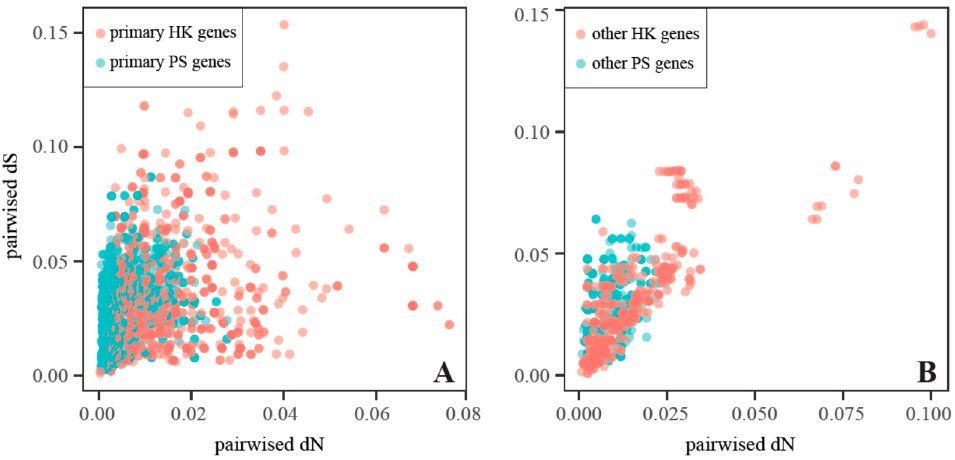
Figure 6. Bivariate plots of pairwise synonymous ( d S ) and nonsynonymous ( d N ) substitution rates of the protein-coding genes from the Myrsinaceae s.str. cp genomes. ( A ) Bivariate plot of the d N vs. the d S of primary housekeeping (HK) and photosynthetic (PS) genes, ( B ) bivariate plot of the d N vs. the d S of the other HK and PS genes.